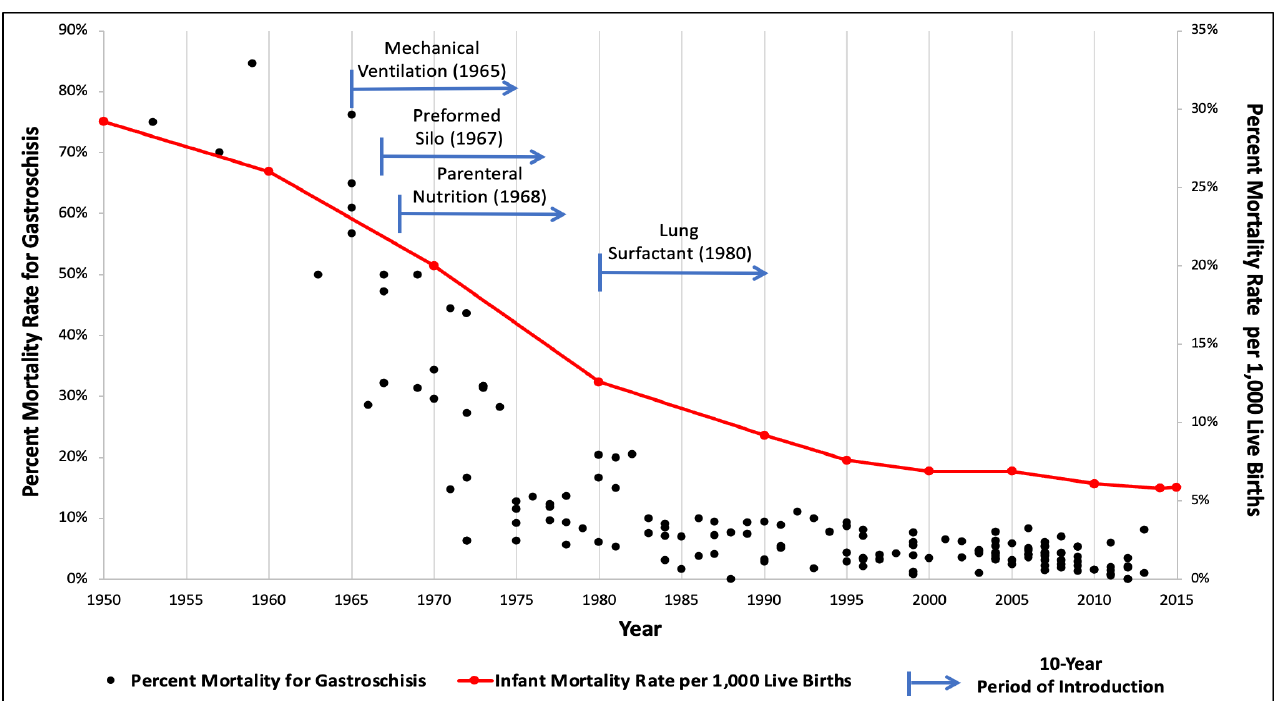
Figure 1. Gastroschisis and infant mortality rates compared over time with associated introduction of medical and surgical innovations.